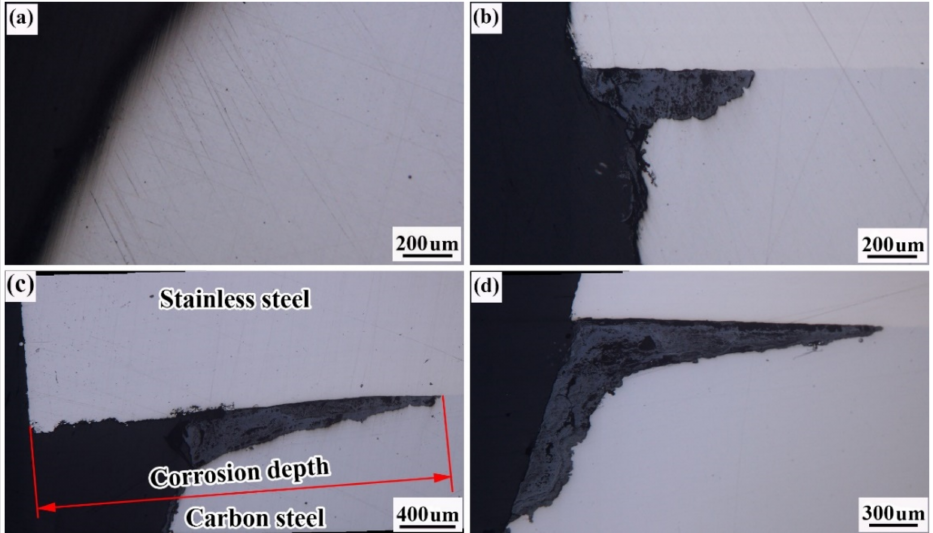
Figure 18. Schematic of corrosion depths on reinforcement ends: ( a ) epoxy seals; ( b ) sleeve joints; ( c ) without sealing treatment; ( d ) welded seals.